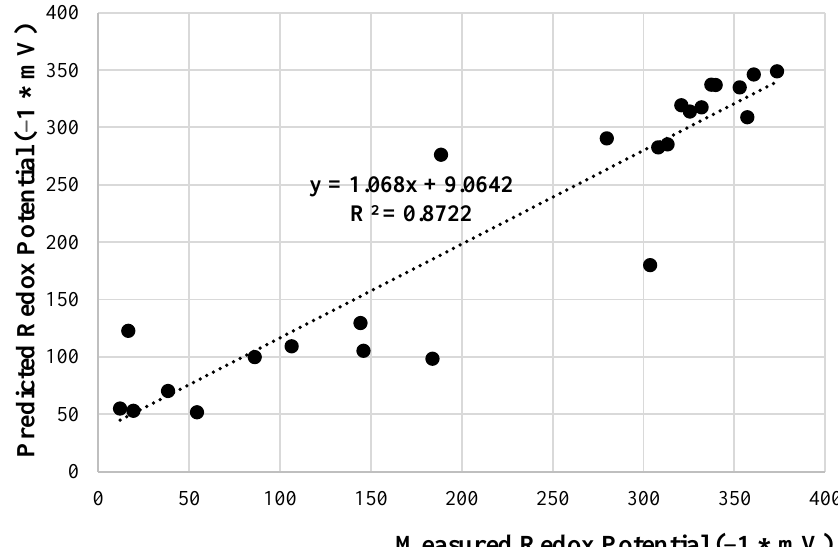
Figure 6. Predicted vs. measured redox potential.